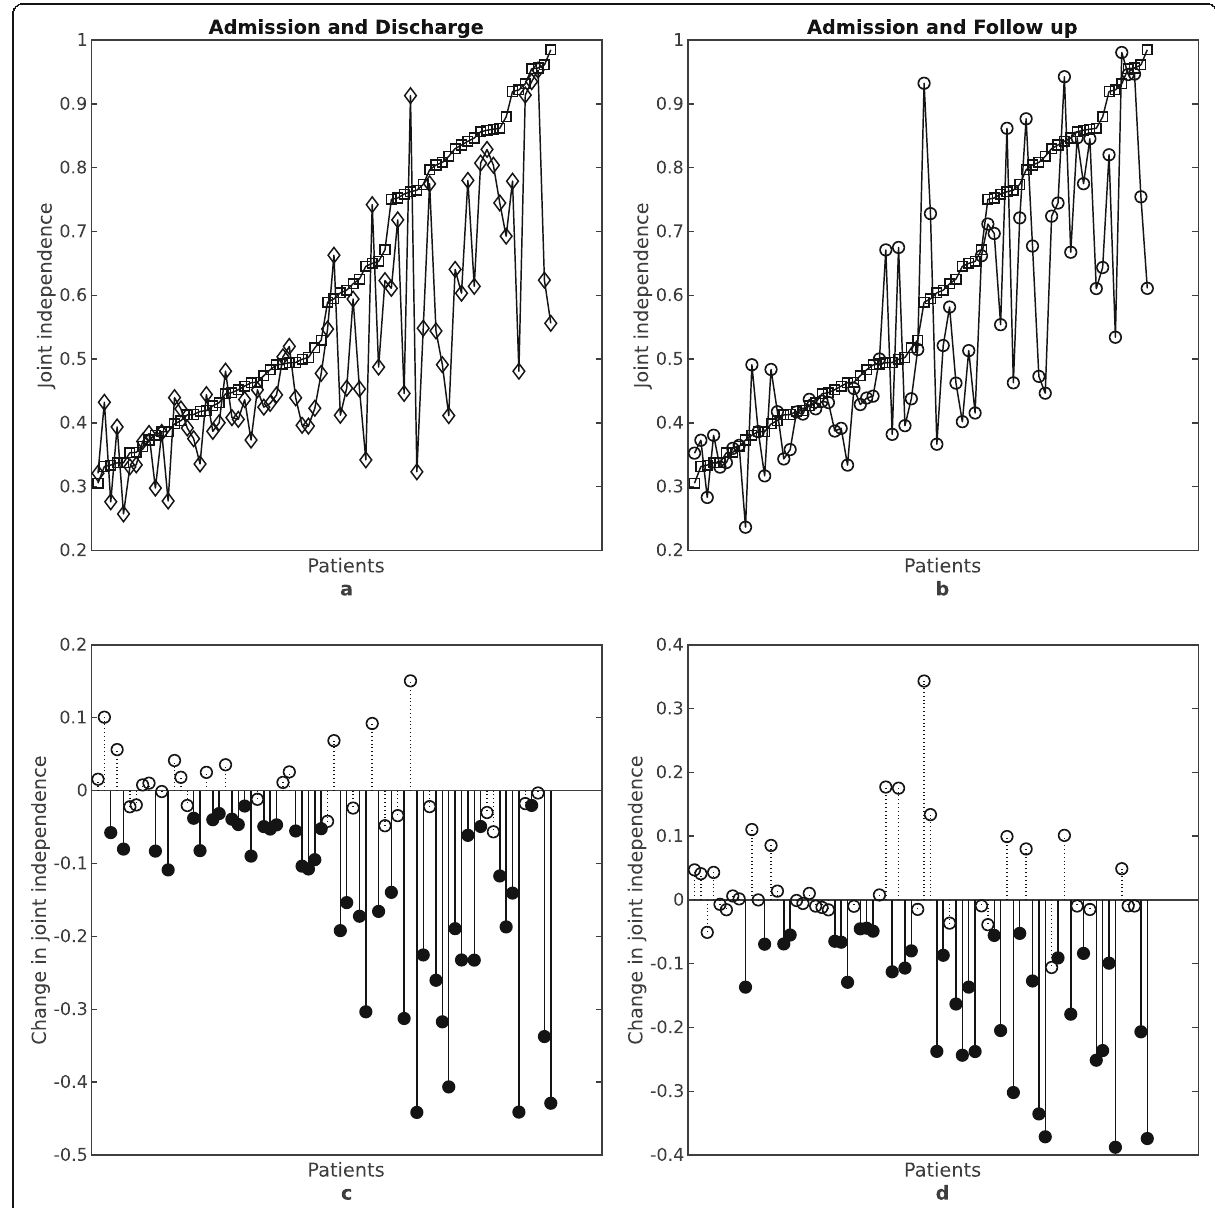
Fig. 4 Improvements in joint independence over time. To afford direct comparison with Figs. 4 and 5 of (Dipietro et al., 2007), here we employed the same non-corrected significance at P < .05 level. Individual values of joint independence metric ( a and b for all patients), sorted by their performance at admission (squares) in comparison to discharge (diamonds), and follow-up (circles). A lower number indicates greater/improving joint independence. Figures c and d represent changes in the joint independence metric, where filled circles indicate significance at discharge ( c ) and follow-up ( d